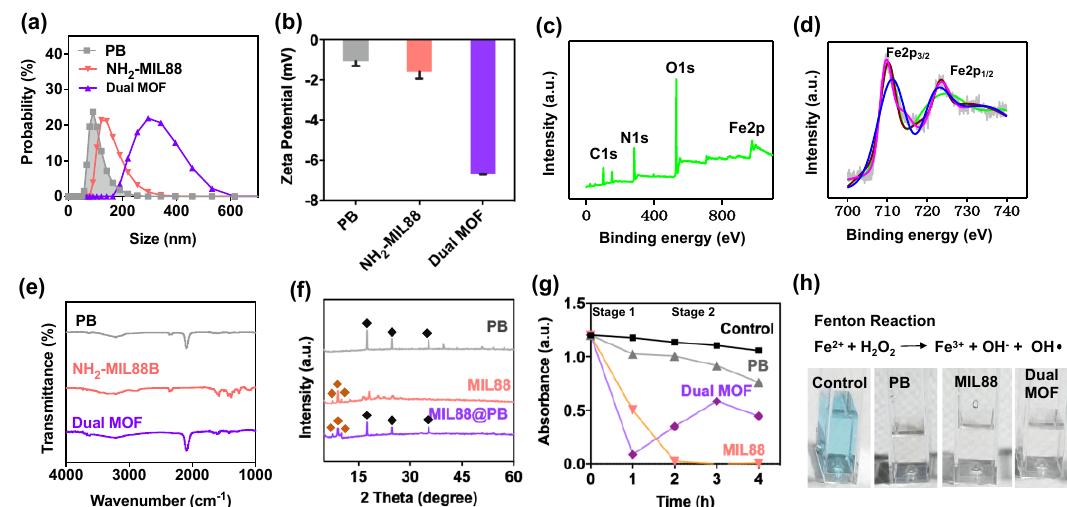
Figure 2. Characterizations of single and dual MOFs. ( a ) Size distribution and ( b ) zeta potential ofPB, MIL88, and dual MOFs. ( c ) XPS spectrum of all the elements and ( d ) Fe2p spectrum of dual MOFs, demonstrating all the iron components in the trivalent state. ( e ) FTIR and ( f ) X-ray diffraction spectrum of PB( ), MIL88( ), and dual MOF. Slight disappearances reflections of 2-Theta and intensities in the dual MOF were due to the shielding effect of MIL88 on PB. ( g , h ) Catalytic perfor- mance of control, PB, MIL88, and dual MOF.